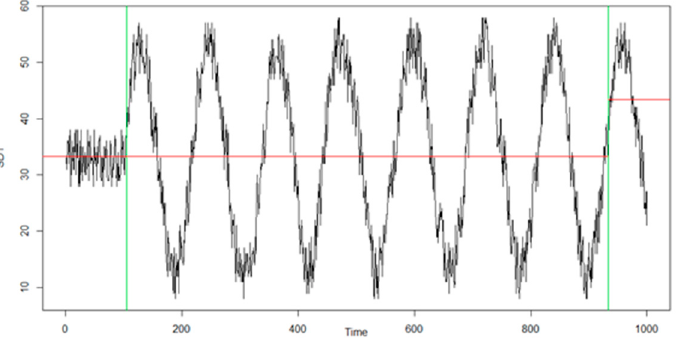
Figure 10. Changes in the variance and mean of the WED data series (own elaboration).